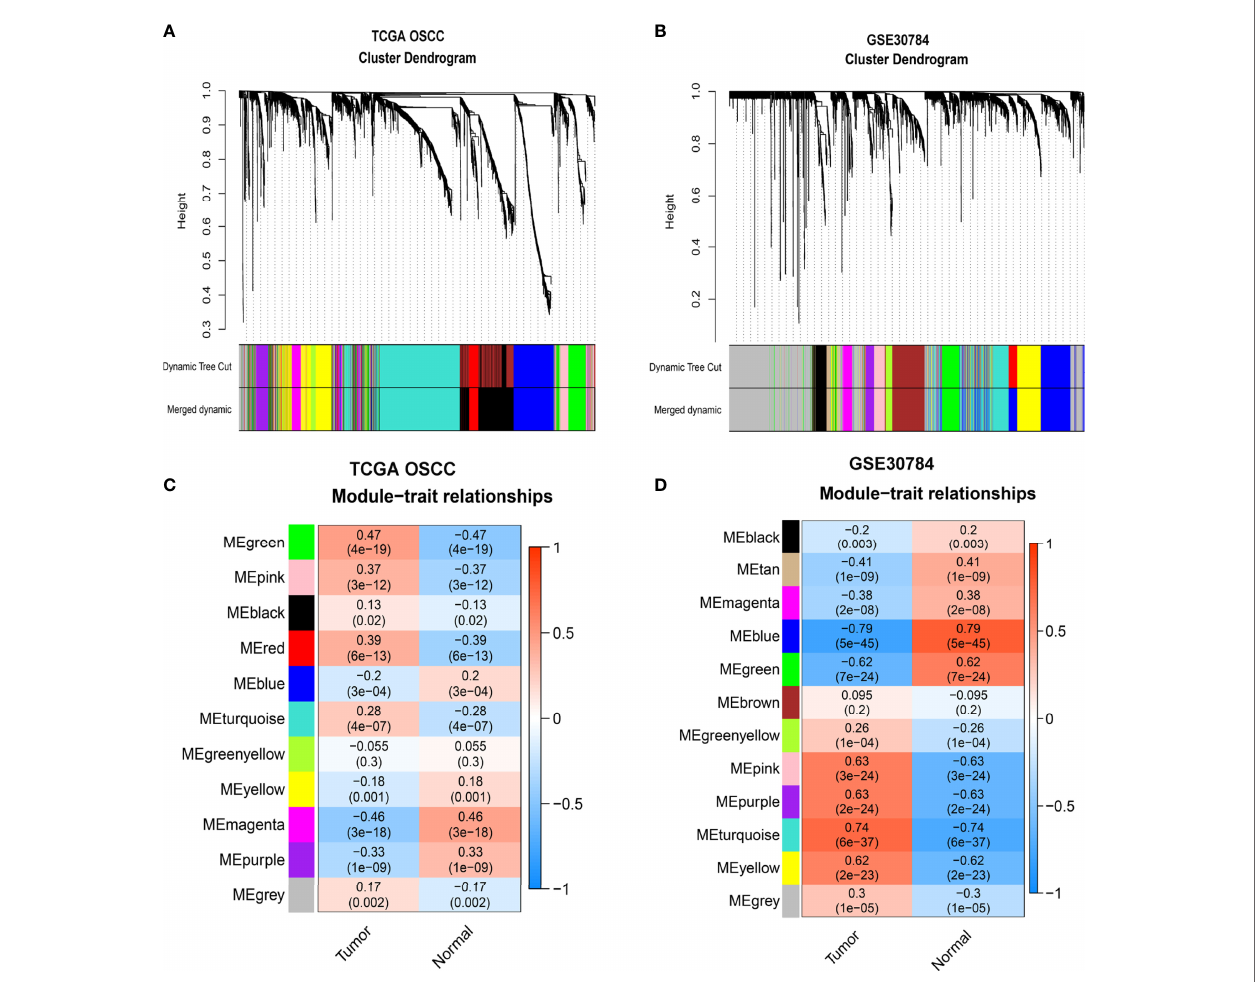
FIGURE 2 | Identi fi cation of modules related to OSCC. (A, B) Hierarchical clustering tree developed by gene dissimilarity based on topological overlap for TCGA- OSCC (A) and GSE30784 datasets (B) . Each color represents a module (gray represents unassigned genes). (C, D) The correlation coef fi cients and p-values of module-trait relationships for TCGA-OSCC (C) and GSE30784 datasets (D) . Each row corresponds to a module eigengene, and each column corresponds to a